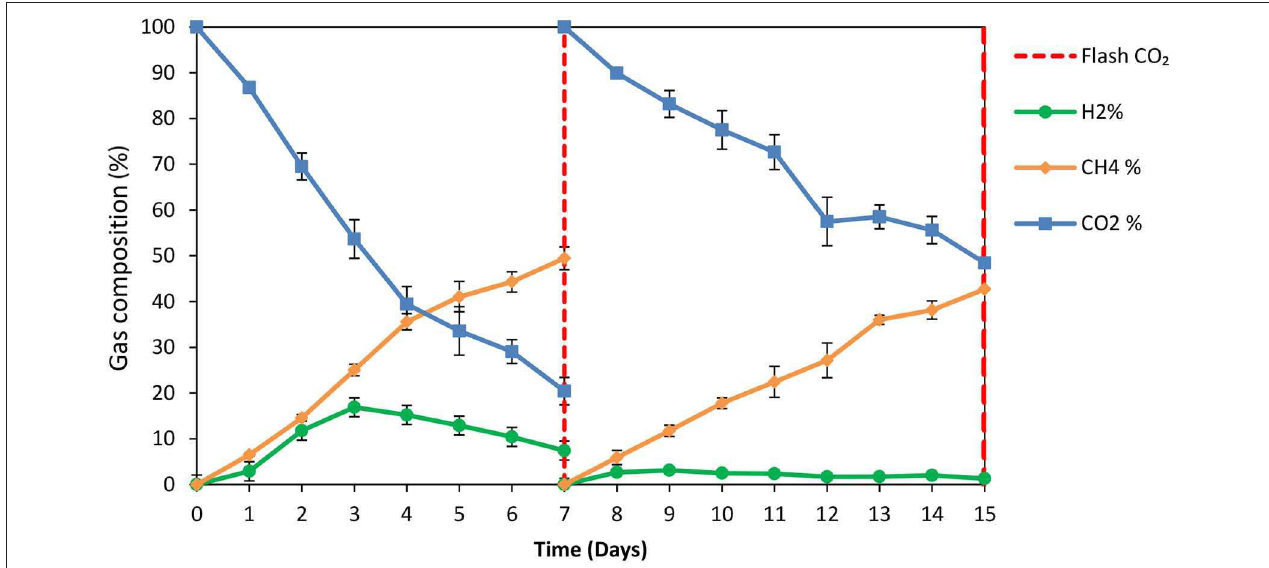
FIGURE 1 | Gas composition over time for anaerobic granular sludge which the pH was daily regulated to pH 3 (after 7th day) in the presence of 100 g/L ZVI. On day 7 the bottles were flushed with CO 2